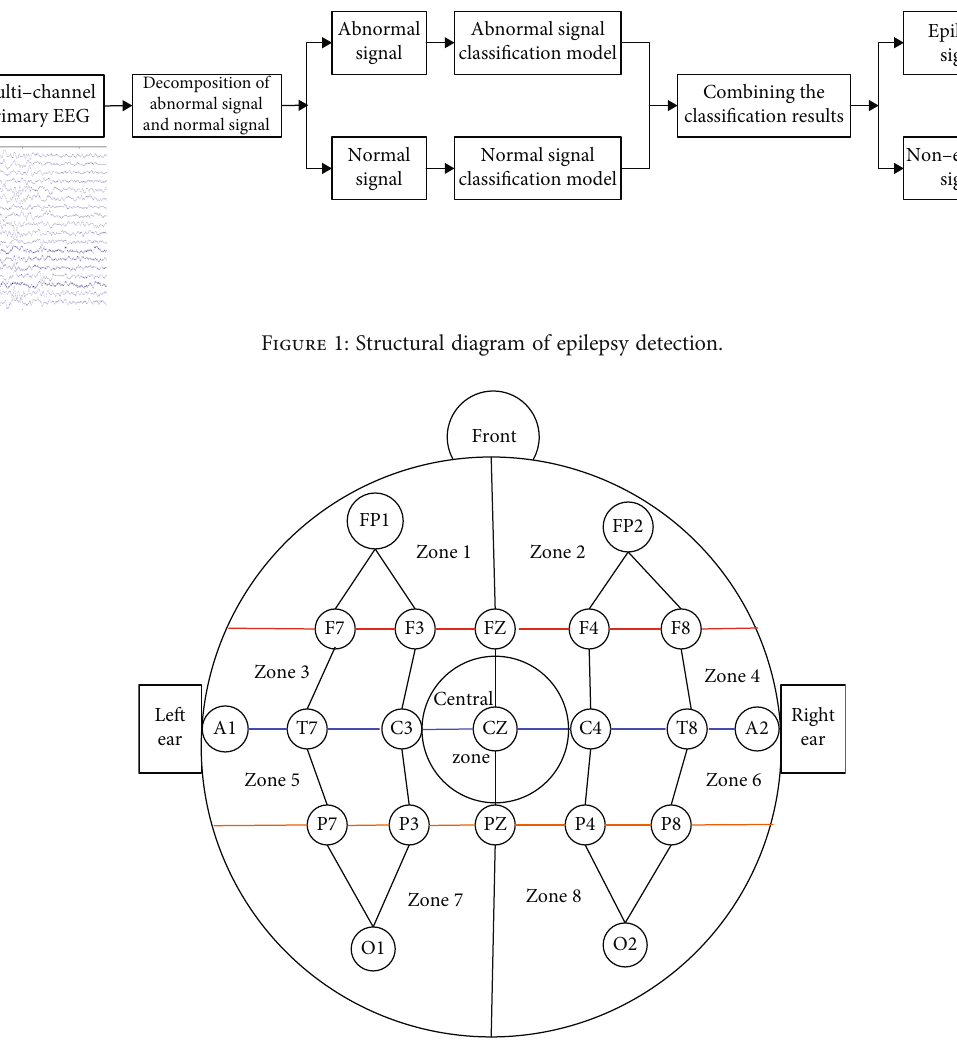
Figure 2: Region